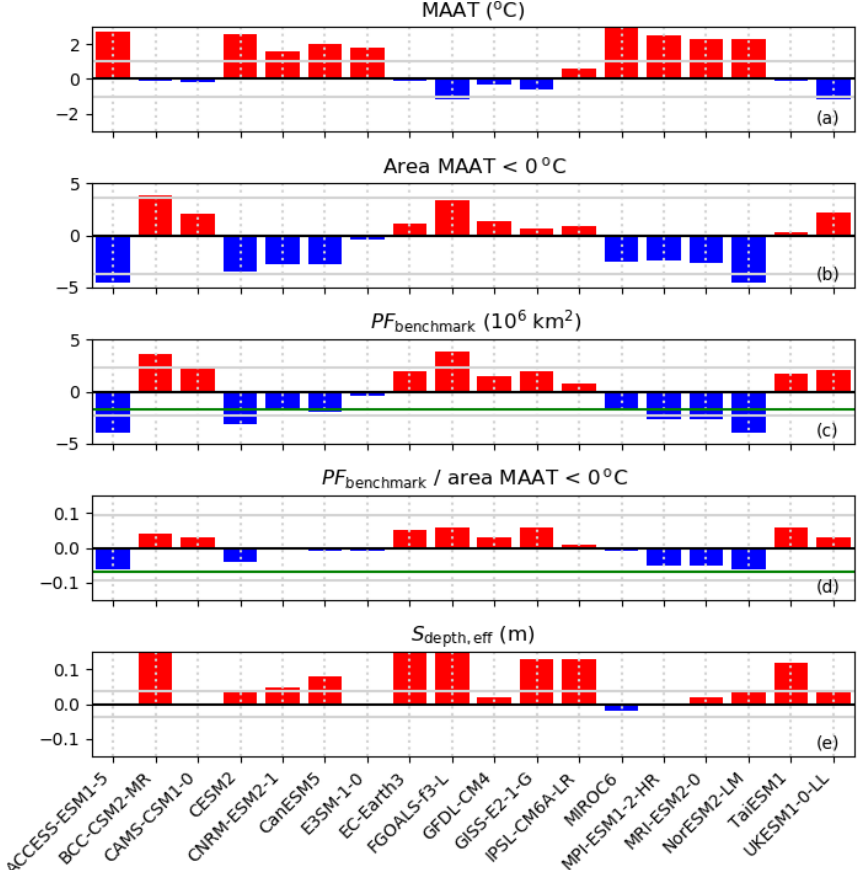
Figure 3. The climate characteristics of the CMIP6 multi-model ensemble compared with the observations for the period 1995–2014. The air temperature observations are from Weedon et al. (2014); the PF benchmark observations are from Chadburn et al. (2017); and the S depth,eff observations are from Brown and Brasnett (2010). The red bars are where the model value is greater than the observations, and the blue bars are where the model value is less than the observations. S depth,eff is for the period 1998–2016 and has not been uploaded to the CMIP archive for every model. The green lines represent the difference between the Chadburn et al. (2017) data set and the Obu et al. (2019) CCI-PF data (Table